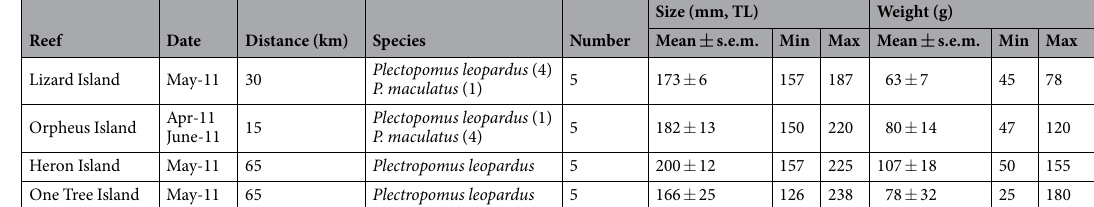
Table 1. Collection information for juvenile coral trout. A total of 20 similarly-sized, juvenile coral trout ( Plectropomus leopardus and P. maculatus ) were collected around four reef islands in the Great Barrier Reef World Heritage Area, Australia, in 2011. Collection reefs and dates, distance from mainland, and number and measurements for coral trout are given. TL = total length, s.e.m. = standard error. The average size and weight of juvenile coral trout collected from the four reef islands did not differ significantly (One-way ANOVA, F 3,16 = 0.89, P = 0.47 for average size; F 3,16 = 0.82, P = 0.50 for average